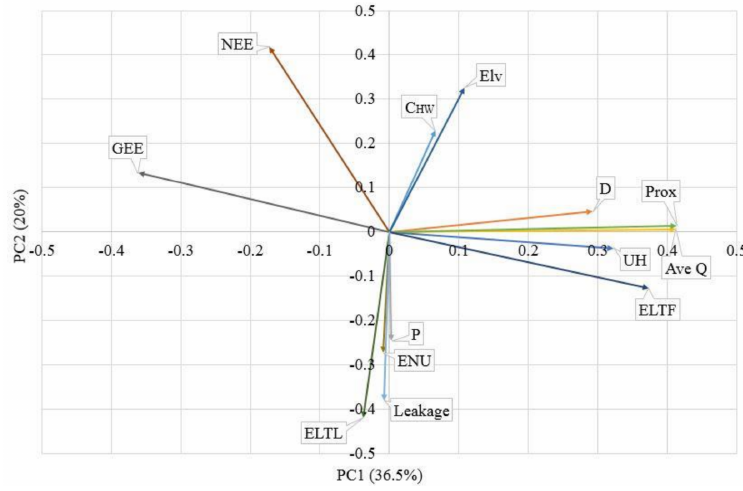
Figure 3. Mono-plot of all variables of interest in the leaky